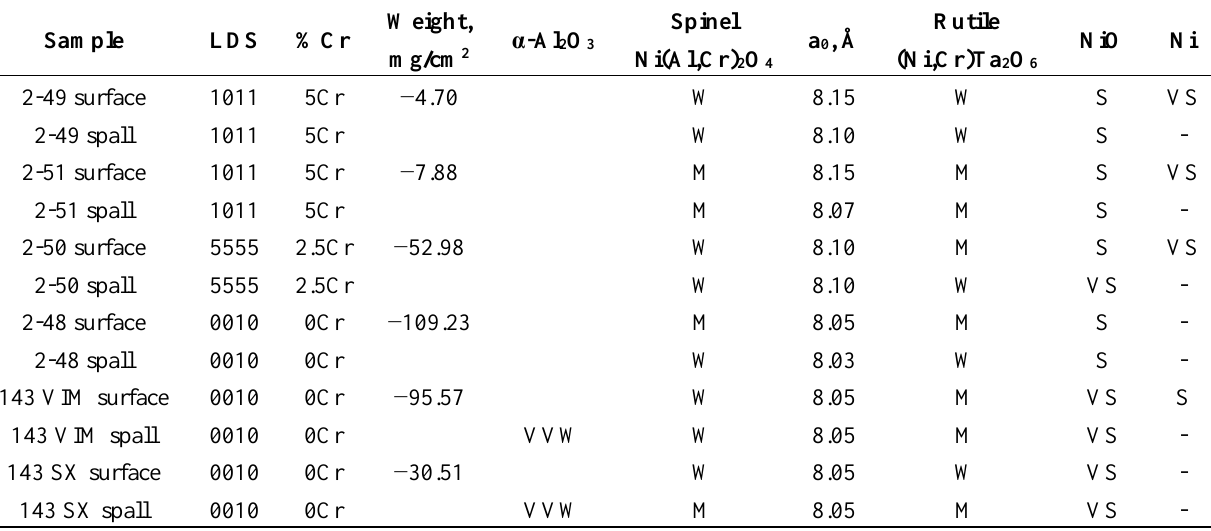
Note: S = strong, W = weak, M = medium, V =